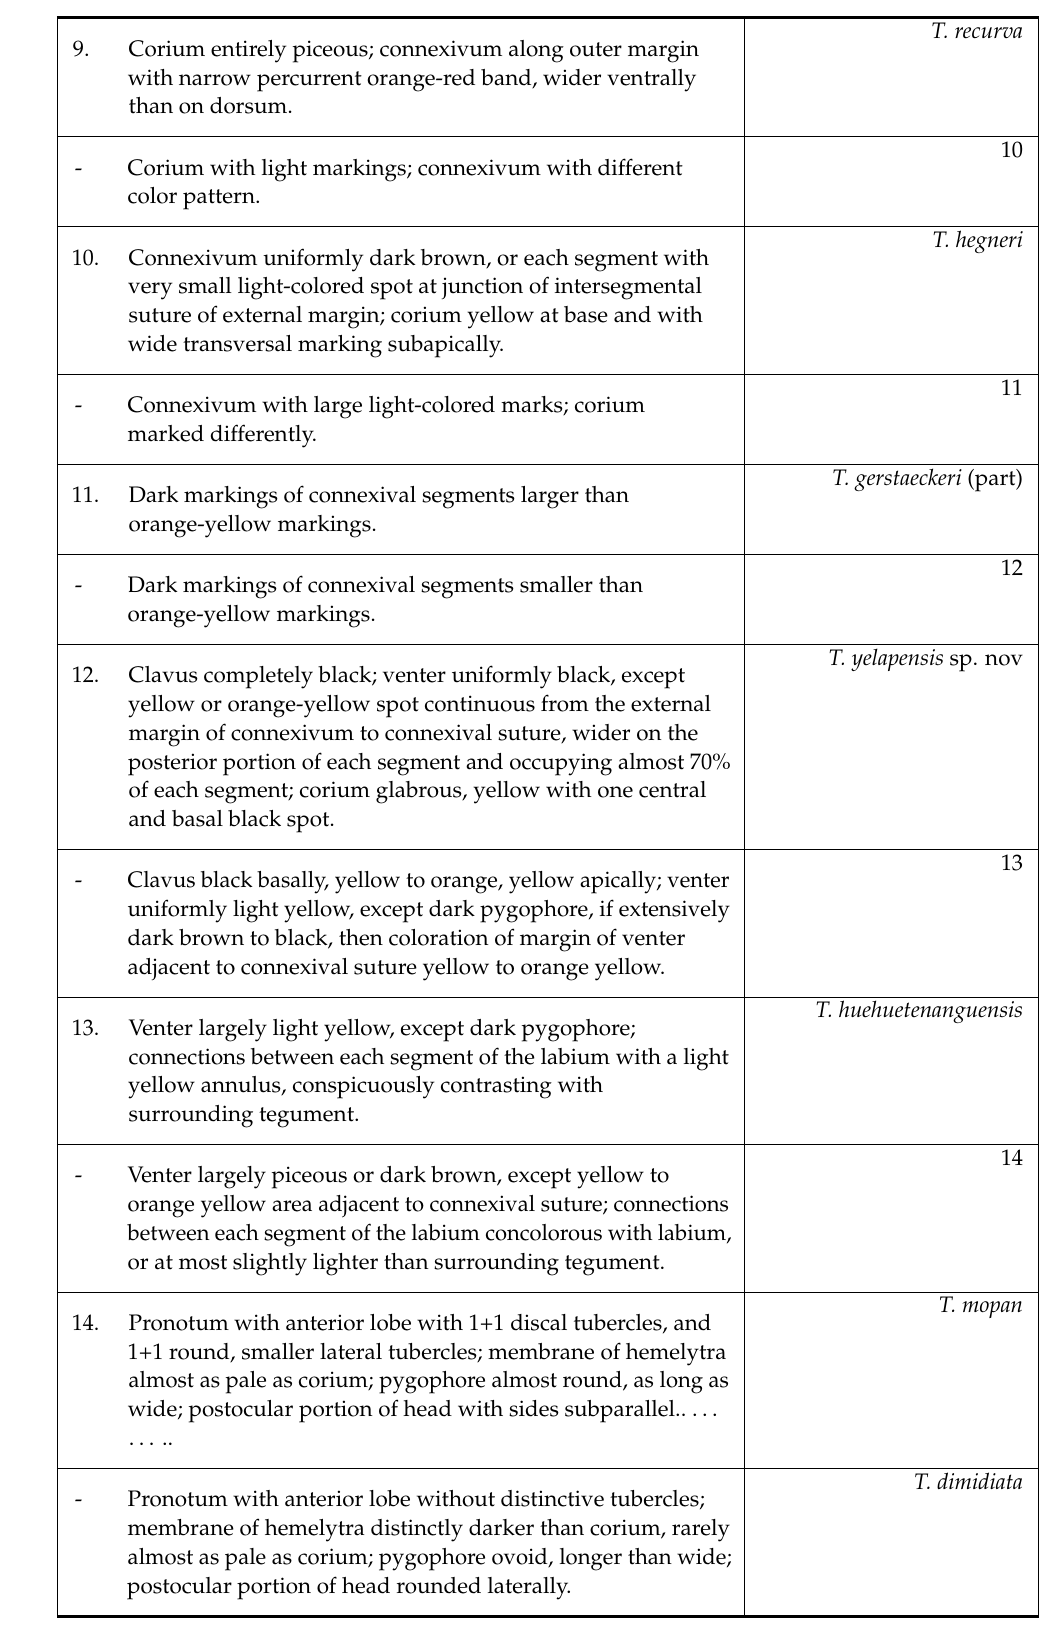
9. Corium entirely piceous; connexivum along outer margin with narrow percurrent orange-red band, wider ventrally than on dorsum. Corium with light markings; connexivum with different color pattern. Connexivum uniformly dark brown, or each segment with very small light-colored spot at junction of intersegmental suture of external margin; corium yellow at base and with wide transversal marking subapically. Connexivum with large light-colored marks; corium marked differently. Dark markings of connexival segments larger than orange-yellow markings. Dark markings of connexival segments smaller than orange-yellow markings. Clavus completely black; venter uniformly black, except yellow or orange-yellow spot continuous from the external margin of connexivum to connexival suture, wider on the posterior portion of each segment and occupying almost 70% of each segment; corium glabrous, yellow with one central and basal black spot. Clavus black basally, yellow to orange, yellow apically; venter uniformly light yellow, except dark pygophore, if extensively dark brown to black, then coloration of margin of venter adjacent to connexival suture yellow to orange yellow. Venter largely light yellow, except dark pygophore; connections between each segment of the labium with a light yellow annulus, conspicuously contrasting with surrounding tegument. Venter largely piceous or dark brown, except yellow to orange yellow area adjacent to connexival suture; connections between each segment of the labium concolorous with labium, or at most slightly lighter than surrounding tegument. 14. Pronotum with anterior lobe with 1+1 discal tubercles, and 1+1 round, smaller lateral tubercles; membrane of hemelytra almost as pale as corium; pygophore almost round, as long as wide; postocular portion of head with sides subparallel.. . . .